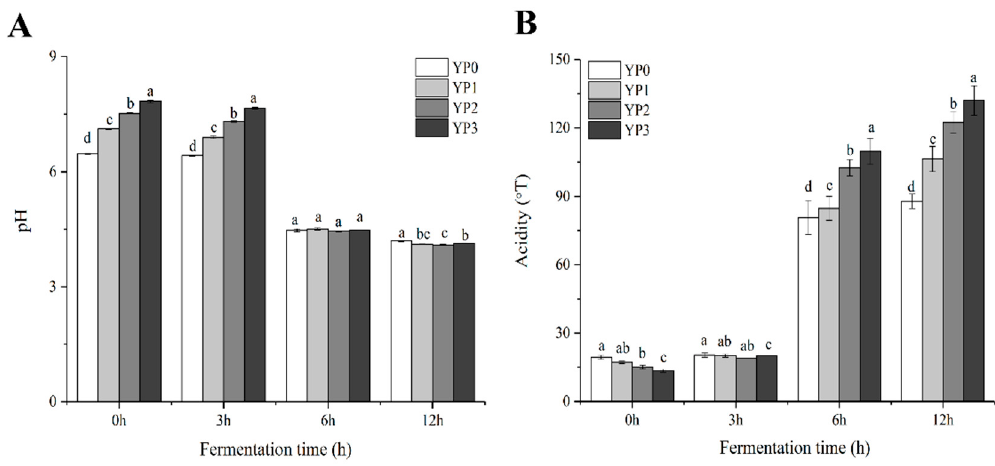
Figure 2. Effects of the addition of PEWH on the pH ( A ) and titratable acid ( B ) of yak milk yogurt. Different letters indicate significantly different ( p < 0.05).